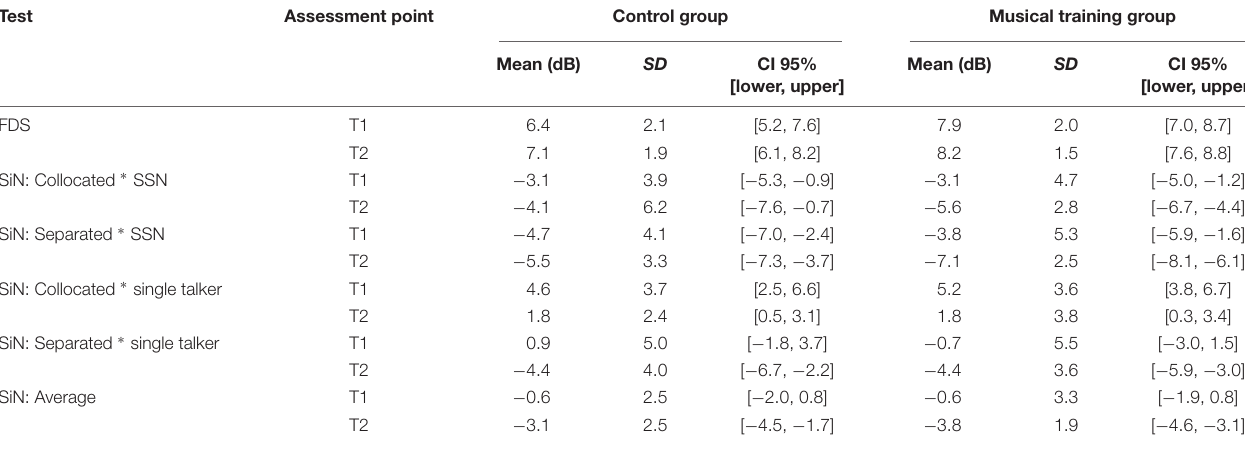
Test Assessment